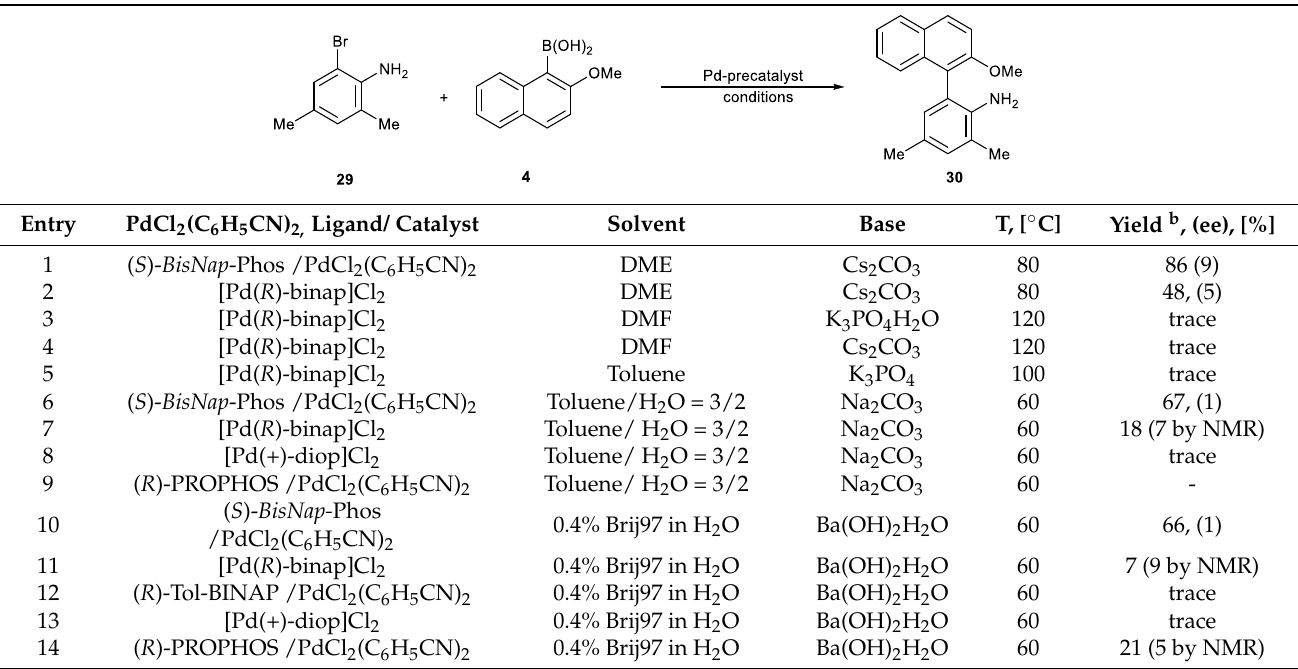
Table 14. Ligand activity in asymmetric synthesis of 1-(2-amino-3,5-dimethylphenyl)-2-methoxynaphthalene ( 30 ) a .